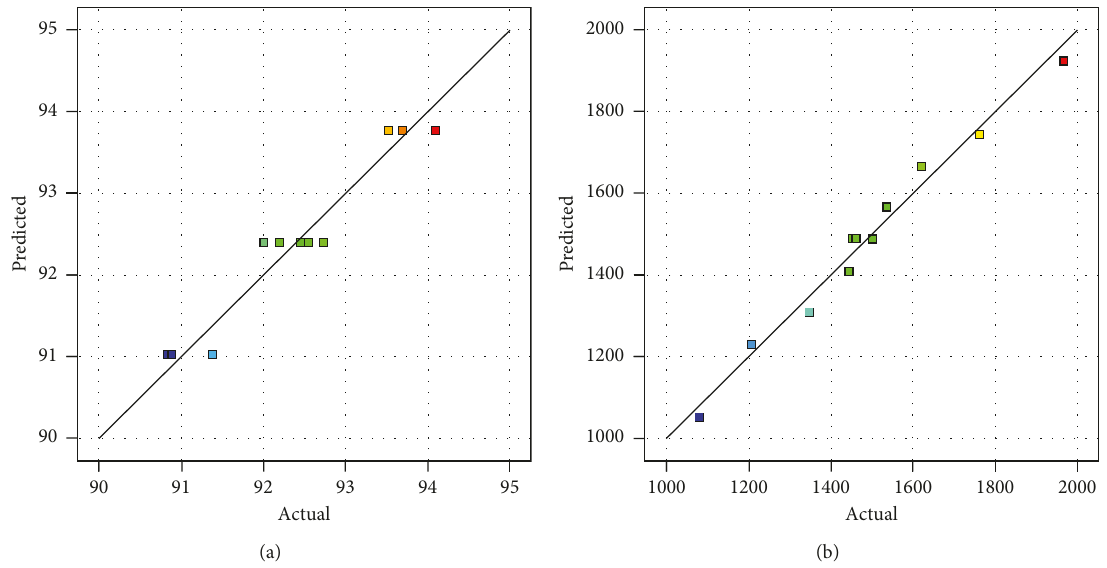
Figure 5: The comparison of predicted and experimental ammonia oxidation efficiency R